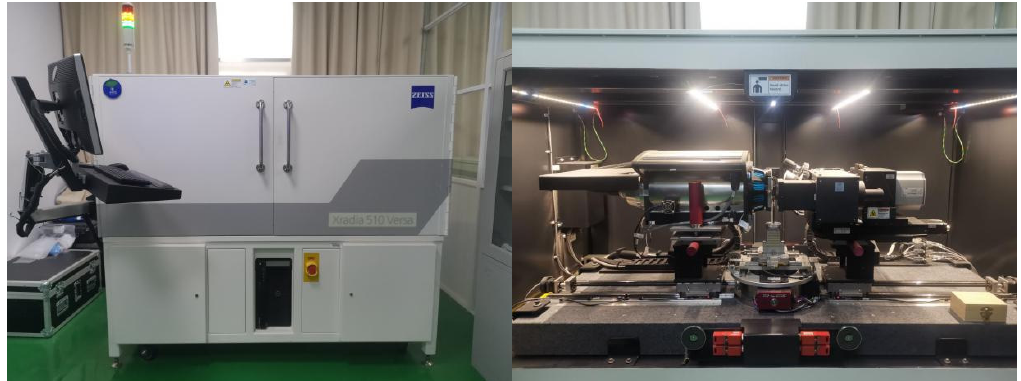
Figure 6 Experimental diagram of the computed tomography (CT) scanning test. Figure 6. Experimental diagram of the computed tomography (CT) scanning